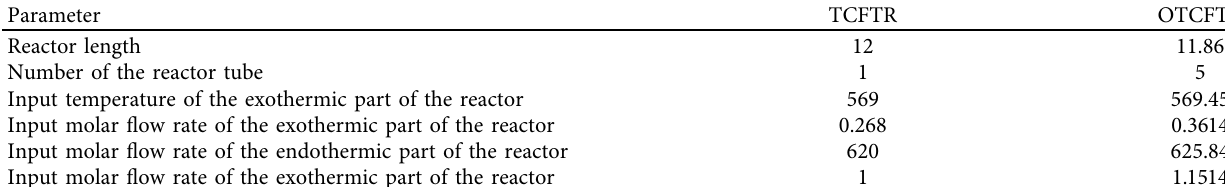
Table 3: Genetic algorithm optimization parameters.